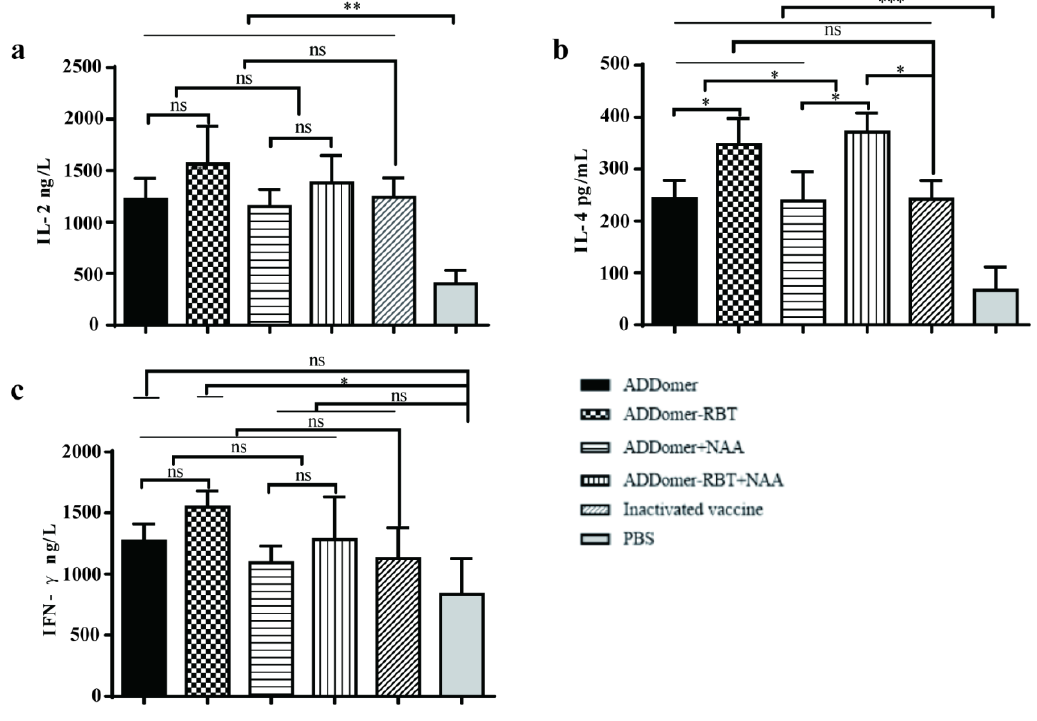
Figure 6. The levels of IL-2, IL-4, and IFN- γ cytokines in sera from mice detected by ELISA. Cyto- kines in sera were measured in serum samples at 2 wk post last immunization. ( a ) Level of IL-2 in sera; ( b ) level of IL-4 in sera; ( c ) level of IFN- γ in sera. Data represent the mean ± SEM. * represents significant difference from the PBS group ( p < 0.05), where * represents p < 0.05; ** represents p < 0.01; *** represents p < 0.001; ns represents non-significantly different from PBS group ( p > 0.05).